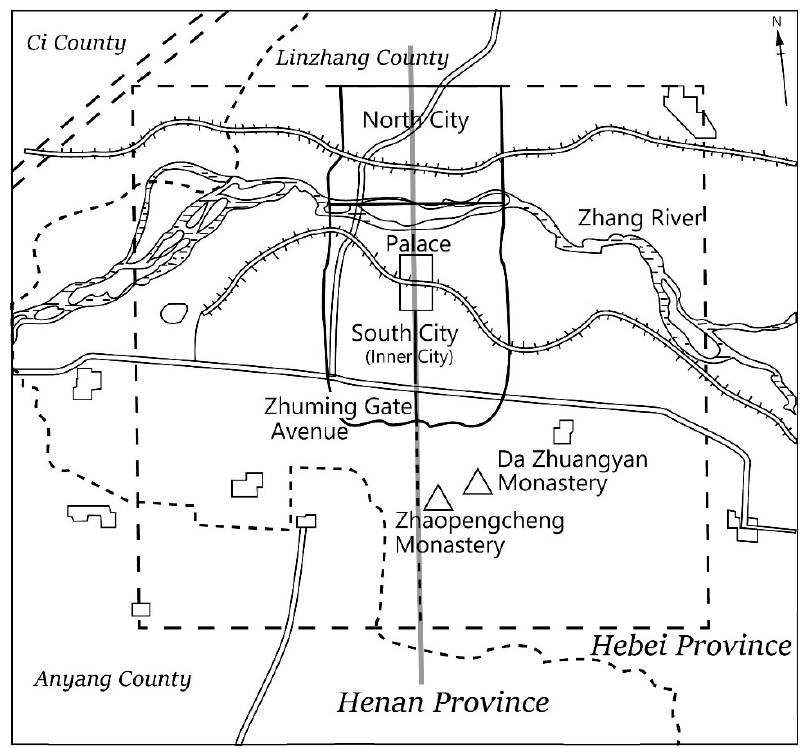
Figure 2. Schematic diagram of the locations of the main imperial Buddhist monasteries in Ye. 12